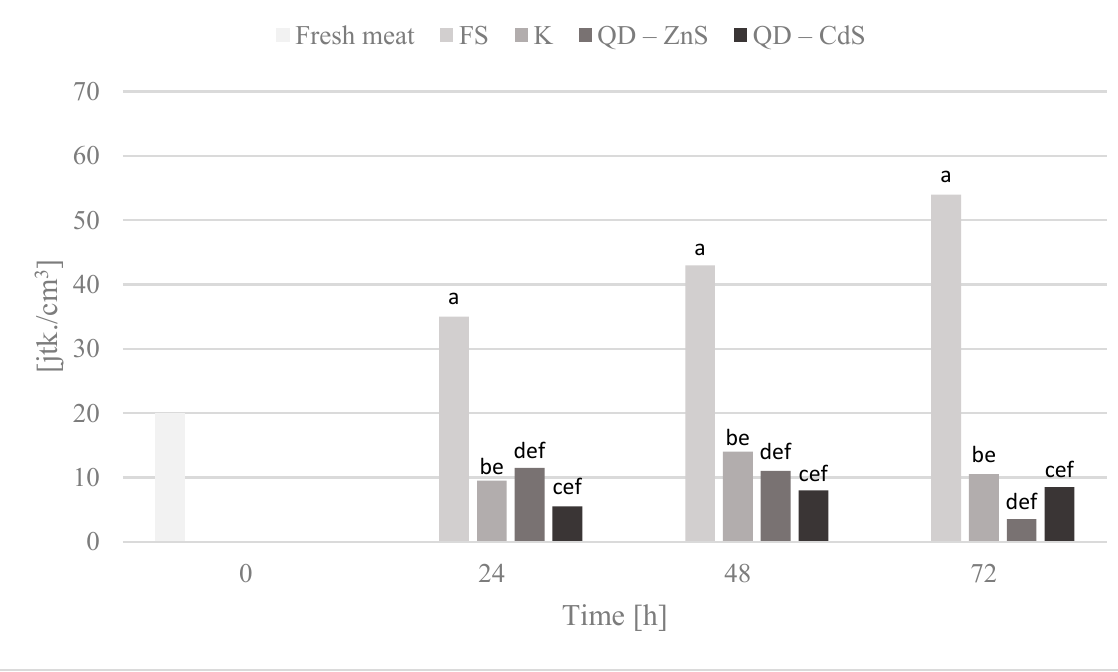
Figure 8. Escherichia coli bacteria count in poultry meat stored under different films at about 4 °C. The parameters in the columns denoted with the same letters (a, b, c, etc.) do not differ statistically at the confidence level of p < 0.05.